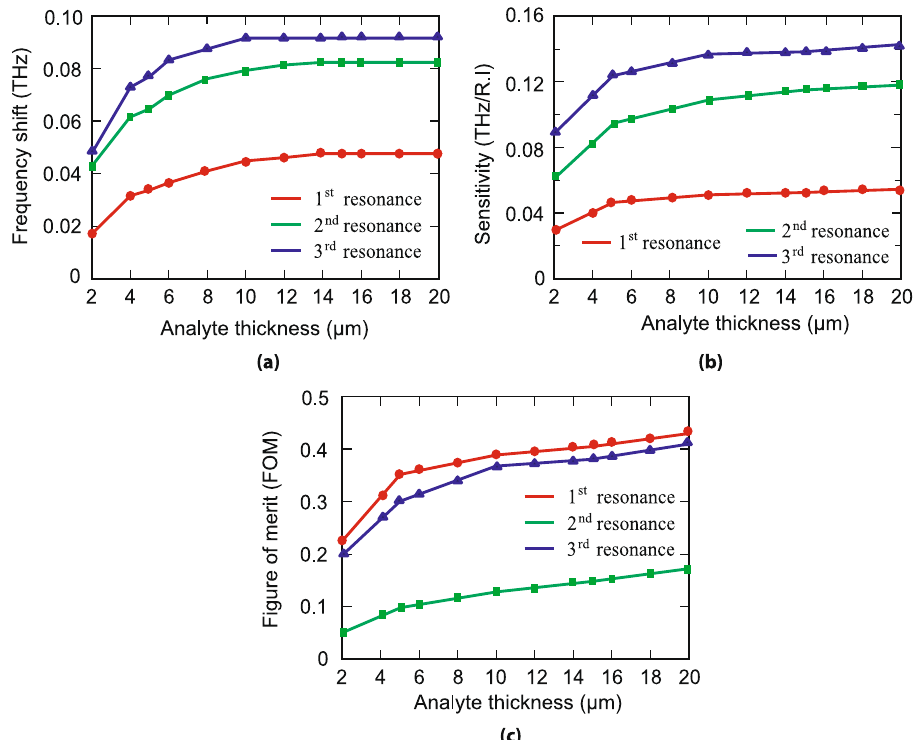
Figure 4. Frequency shift, sensitivity and calculated figure of merit. ( a ) Shows plot of frequency shift corresponding to different analyte thickness with respect to the resonance frequency when there is no analyte for three different resonances. ( b ) and ( c ) depicts the sensitivity and FoMs plots, respectively for different thicknesses corresponding to three different